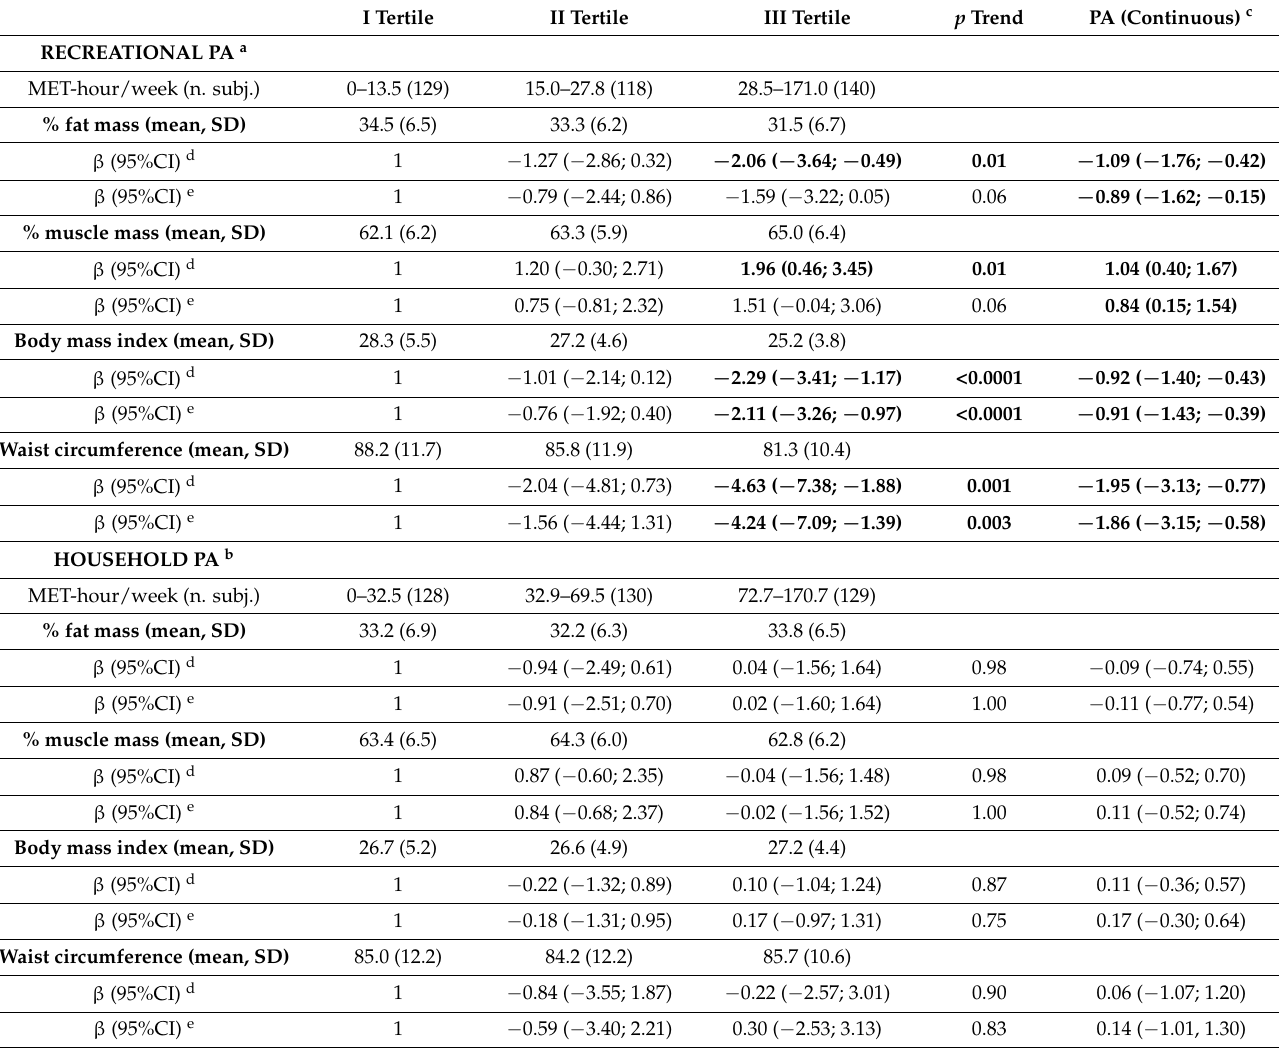
Table 3. Association between physical activity and percentage fat mass, percentage muscle mass, body mass index, and waist circumference in the 388 EPIC-Florence participants, with follow- up information. I Tertile II Tertile III Tertile p Trend PA (Continuous)